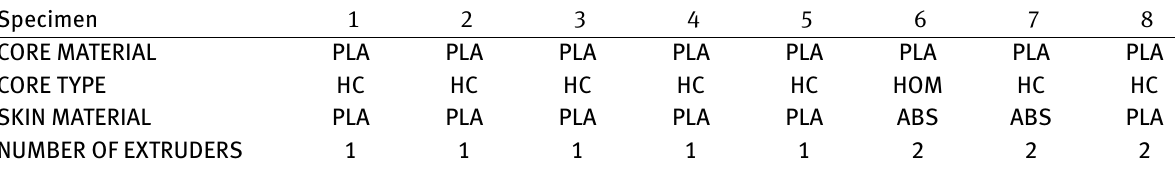
Table 1: Lamination scheme of the eight specimens. HC means H oney C omb. HOM means HOM ogeneous. Specimen